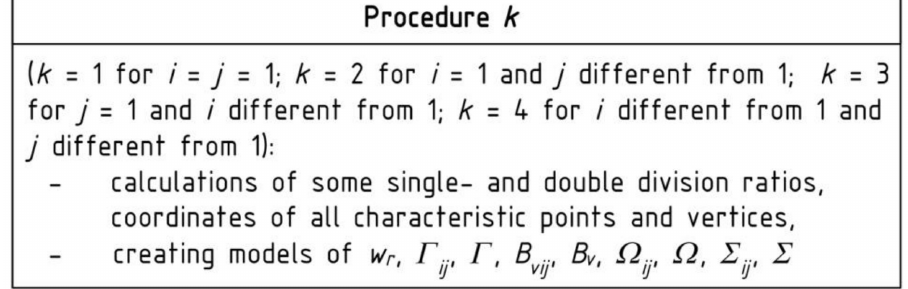
Figure 21. Common operations accomplished by the four configurations Prod k , where k = 1 to